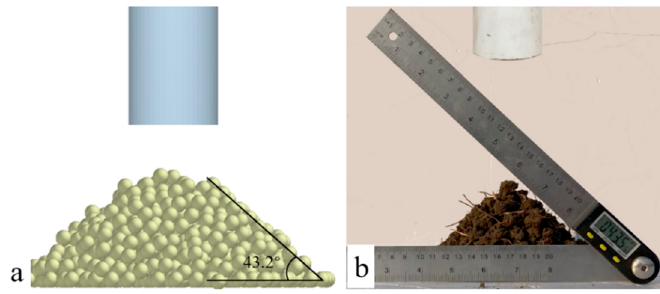
Figure 4. Discrete element simulation model diagram.